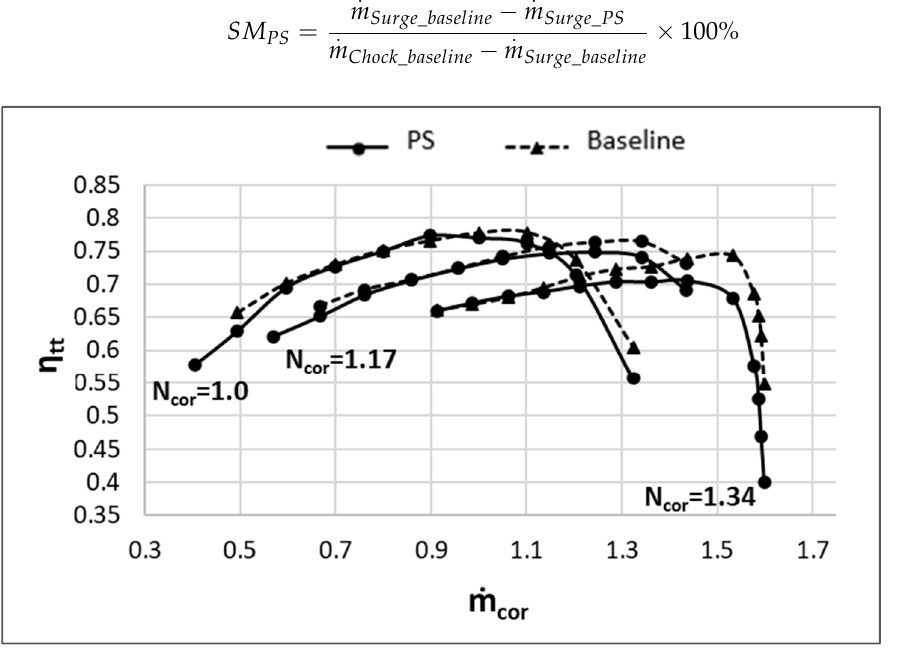
Figure 7. Comparison of the characteristic curve of the isentropic total to total efficiency between the ported shroud case and the baseline case, at different rotational speeds.